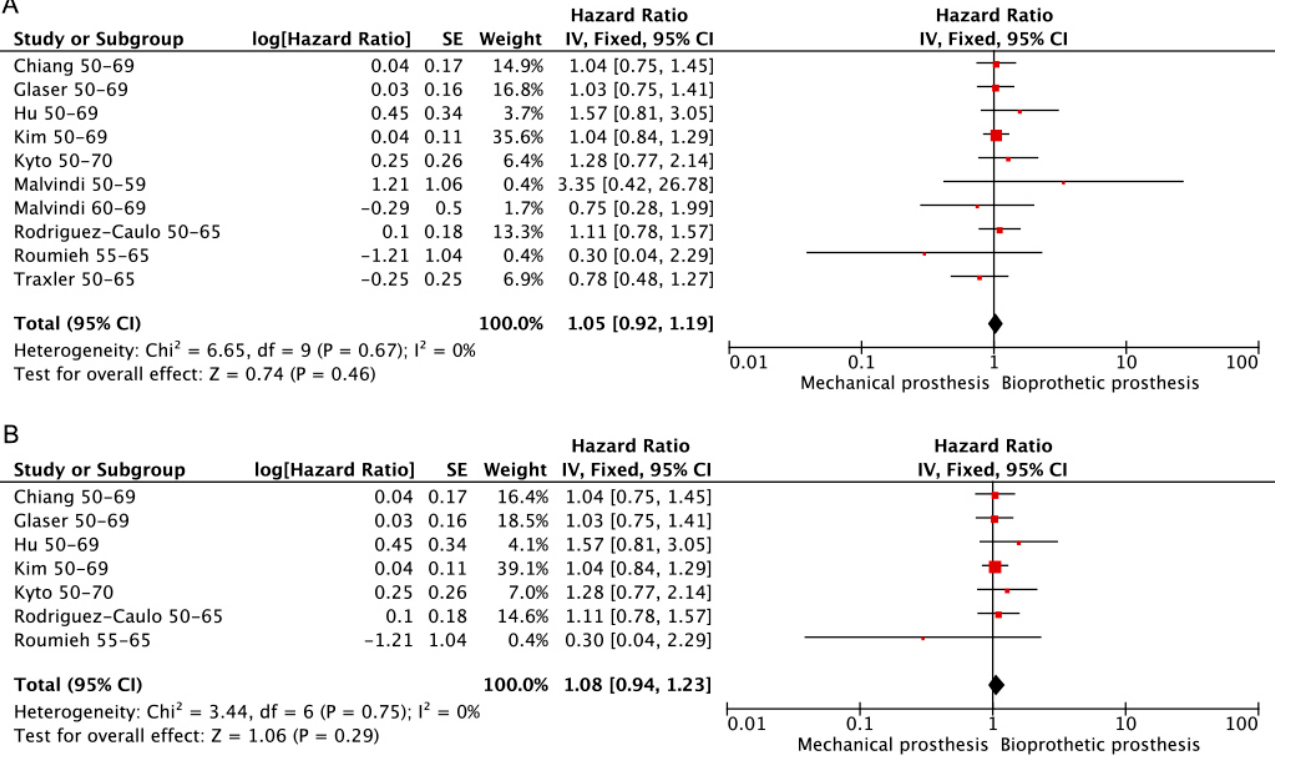
Figure 8. Meta-analysis for freedom from stroke. ( A ) Bioprosthetic vs. mechanical. ( B ) Bioprosthetic vs. mechanical (RCT or PSM).